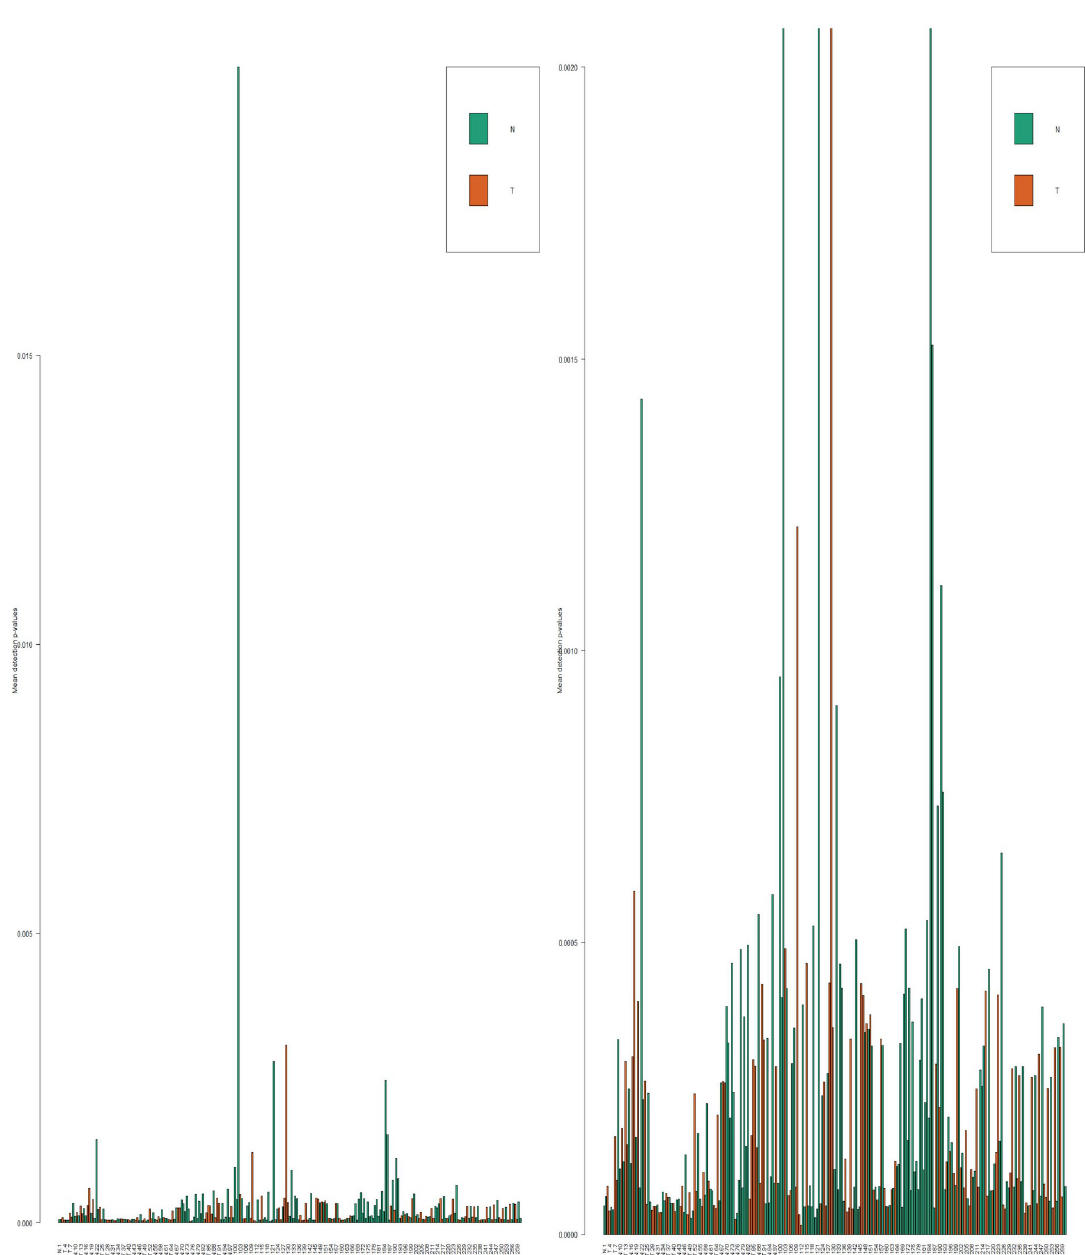
Fig 24. The detected P.values of all samples. The right side is the zoomed model of the left side. As it is shown all samples are in statistically significant